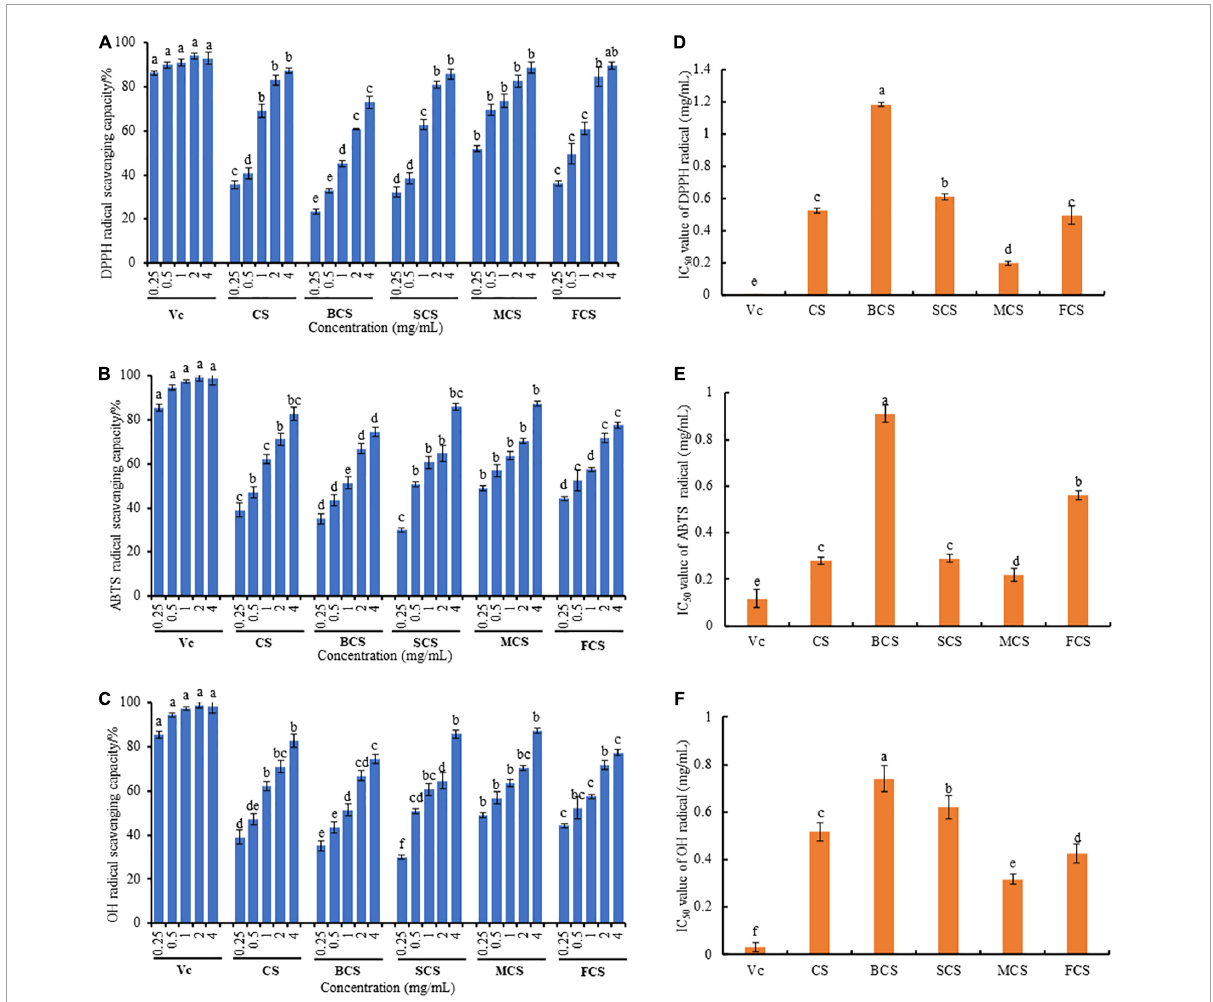
FIGURE2 Effects of cooking methods on antioxidant activity of extracts from C. squamulosa . (A) DPPH radical scavenging activity. (B) ABTS radical scavenging activity. (C) OH radical scavenging activity. (D) IC 50 value of DPPH radical. (E) IC 50 value of ABTS radical. (F) IC 50 value of OH radical. CS, C. squamulosa ; BCS, boiling-cooked C. squamulosa ; SCS, steaming-cooked C. squamulosa ; MCS, microwaving-cooked C. squamulosa ; FCS, frying-cooked C. squamulosa . Each value represents the mean ± SD ( n = 3) and different lowercase letters denote statistical significance ( p <